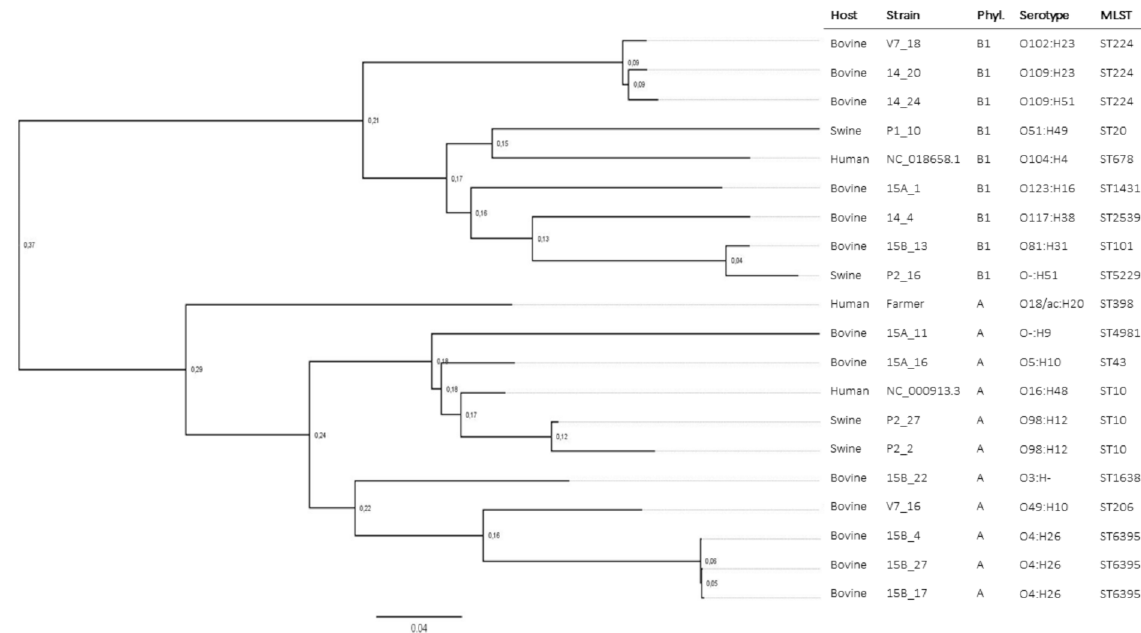
Figure 1. Chromosome phylogeny based on Single Nucleotide Polymorphisms (SNPs) retrieved with CSIPhylogeny and visualized with FigTree. Isolates are clustered according to phylotype and serotype. Two E. coli references were included that belonged to different phylotypes: NC_018658.1 for phylotype B1, and NC_000913.3 for phylotype.